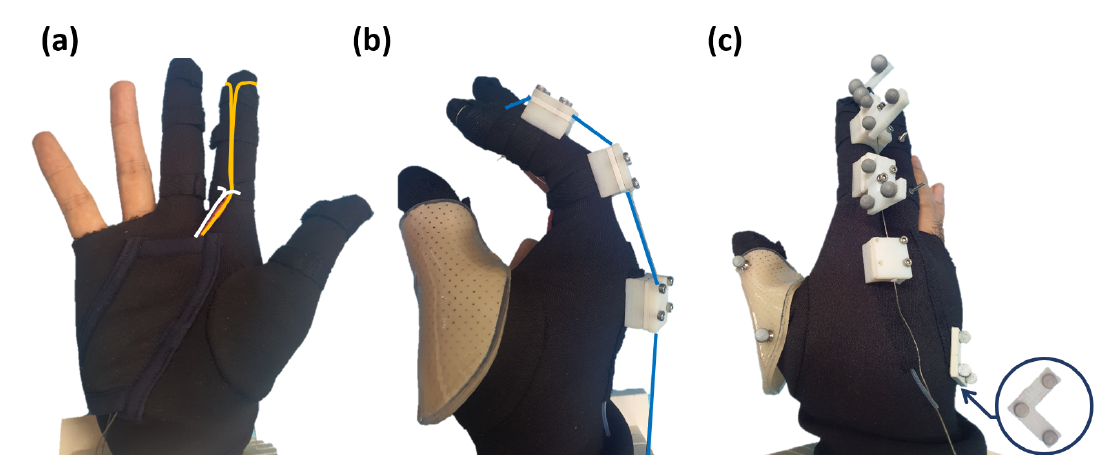
Figure 3. Overall view of Exo-Index: ( a ) shows two flexors (yellow line means All Flexor (A.F.) while the white line shows MCP Flexor (M.F.)) in a hand-open position, ( b ) shows an extensor named as All Extensor (blue line) in a hand-held position. In addition, the method of attaching vicon markers is shown in ( c ). Three markers attached on the back side of the hand are considered as the base frame.